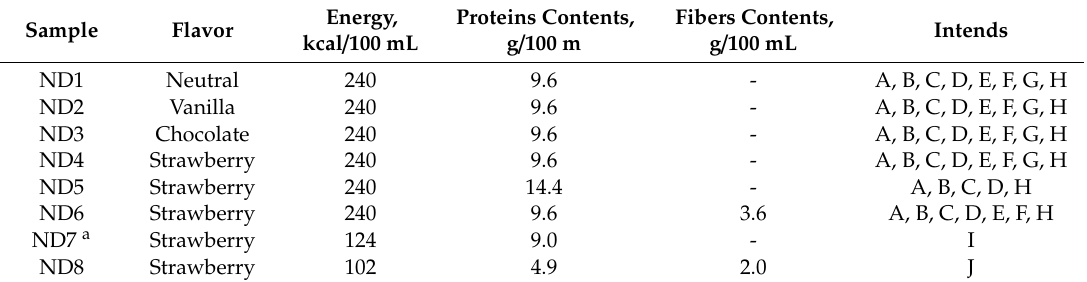
Table 5. Examined nutritional drinks